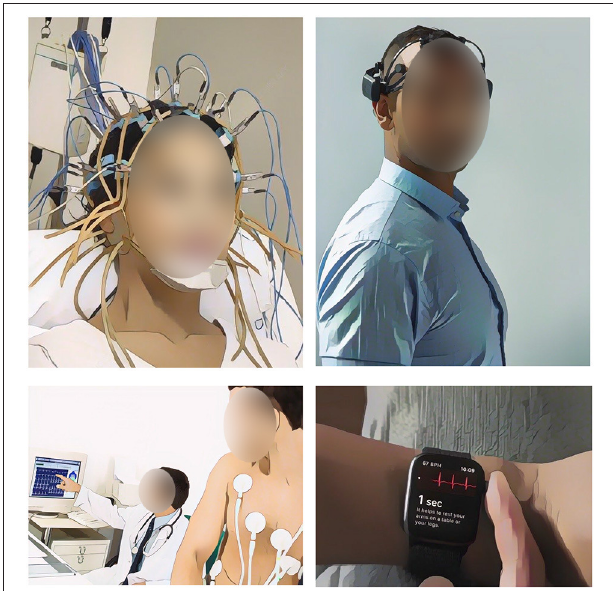
FIGURE 4 | Consumer-grade BCI devices substantially improved the comfort and wearability, permitting devices to be used in new contexts and new types of questions to be asked. Top left, a standard wet EEG system, earlier systems were very susceptible to movement artifacts. Top right, a wireless headset by Emotiv, still uses wet electrodes but the setup is much quicker and wearability much improved compared to earlier systems. Bottom left, ECG setup found in most clinics, the setups commonly use 10 sticky electrodes to monitor cardiac activity. Bottom right, today’s wrist-worn smartwatches can report user’s ECG from the press of a